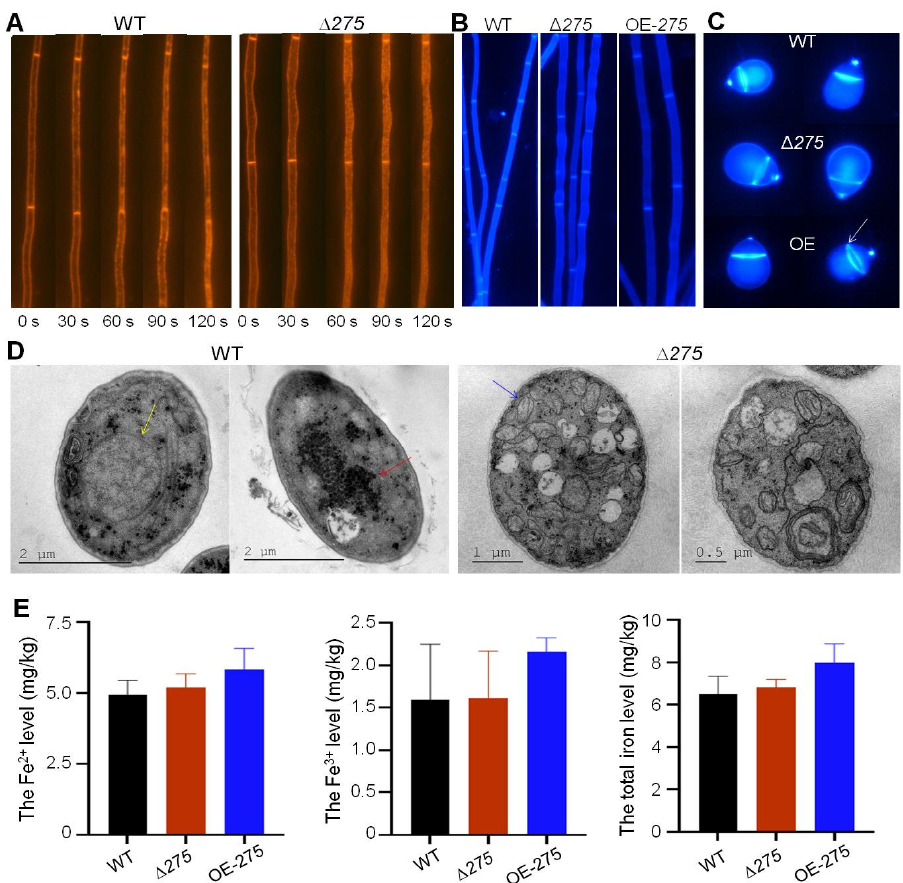
Figure 8. The effect of 275 on the fungal endocytosis, septum formation, infrastructure, and iron levels: ( A ) Comparison of the fungal endocytosis between Δ 275 and the WT within 120 s using the lipophilic styryl dye FM-464. ( B ) Comparison of the fungal mycelial morphology and septum for- mation between the mutants Δ 275 and OE- 275 and the WT using CFW staining. ( C ) Comparison of the conidial septum formation between the mutants Δ 275 and OE- 275 and the WT. White arrow: septum. ( D ) TEM analysis of the infrastructures between the mutant Δ 275 and the WT. Yellow ar- row: vacuole; Blue arrow: mitochondria; red arrow: black particles. ( E ) Comparison of the Fe 2+ , Fe 3+ , and total iron levels between the mutants Δ 275 and OE- 275 and the WT.